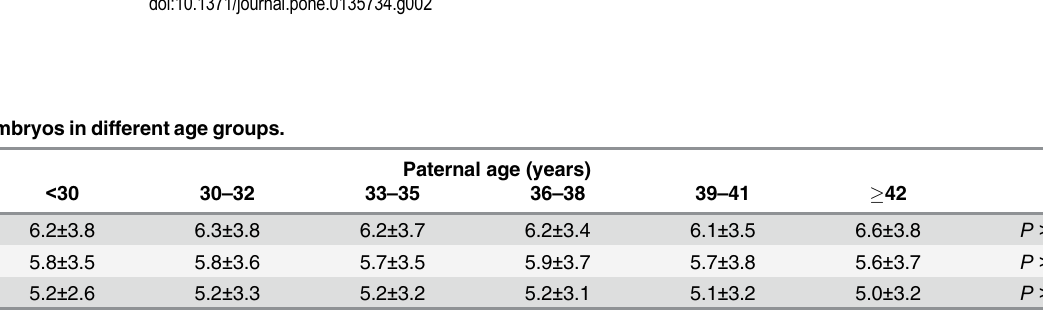
Fig 2. Fertilization rates in different age groups. In each group (maternal age < 30 y, 30 – 34 y, 35 – 38 y), there were no significant differences in fertilization rate among different paternal age subgroups ( P > 0.05).